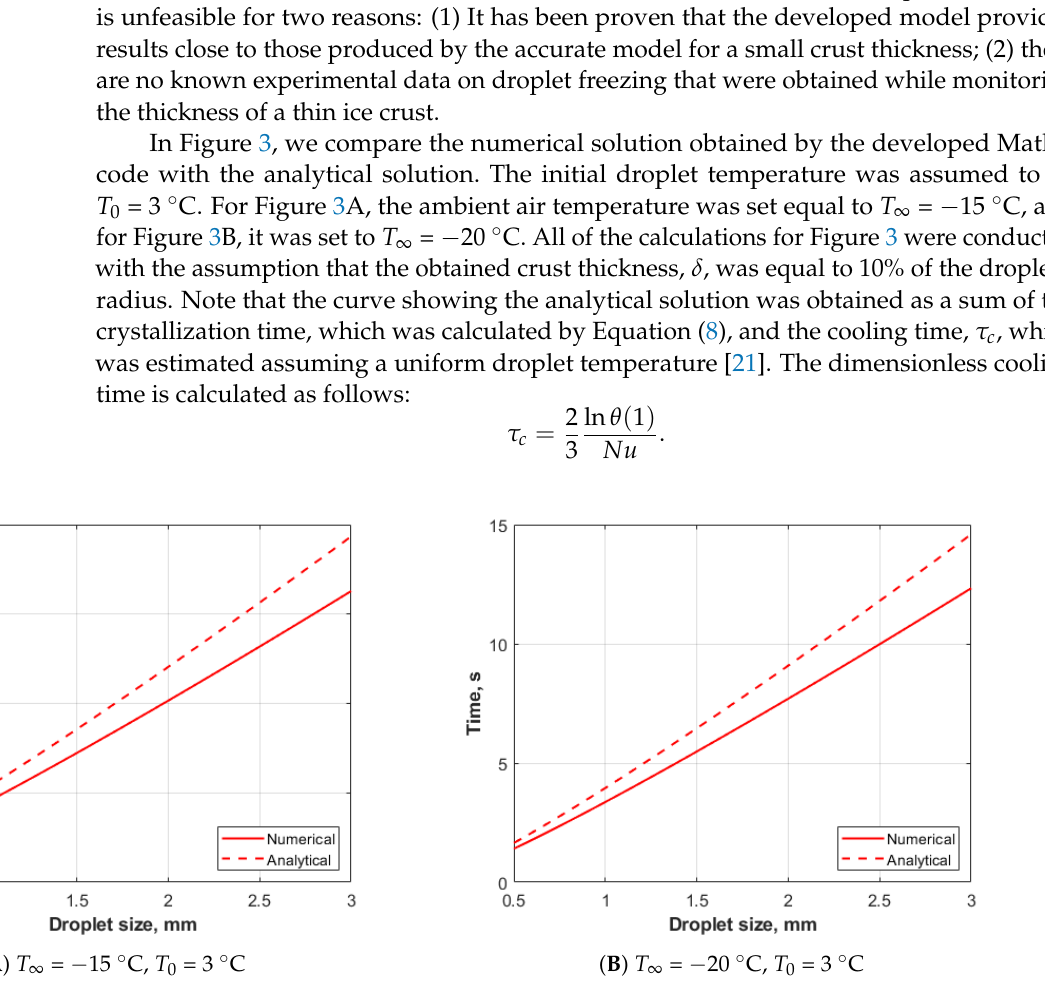
Figure 3. Comparison of the numerical and analytical solutions for the freezing time required to crystallize a layer whose thickness is equal to 10% of the droplet’s